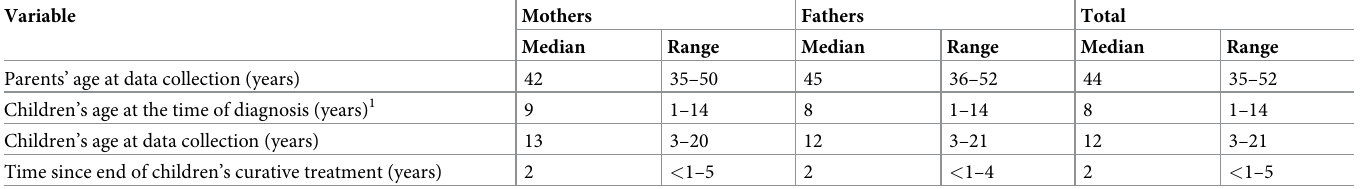
Table 3. Ages of mothers (n = 8) and fathers (n = 7), their child’s age, and time since the end of curative treatment for their child.